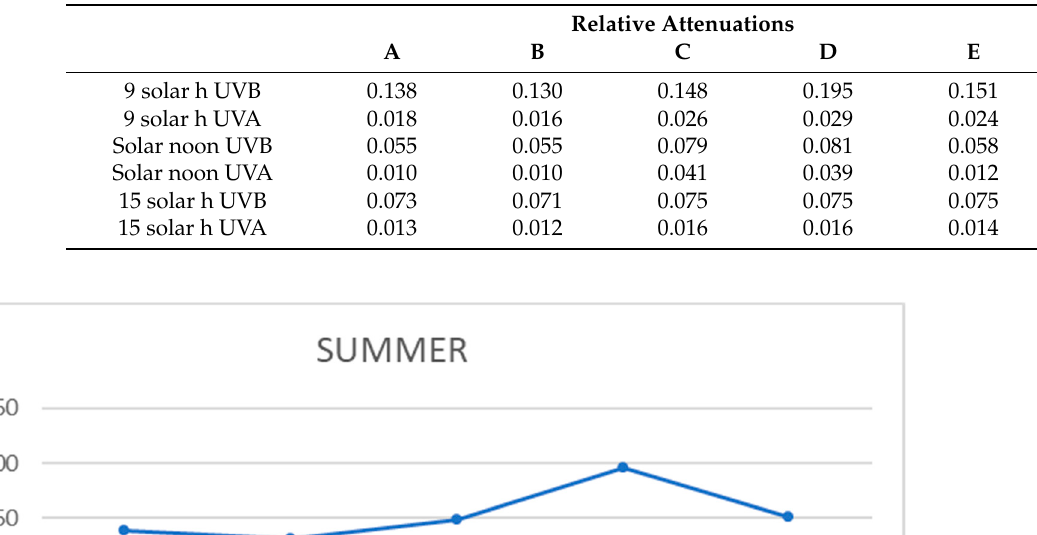
Table 3. Values of mean relative attenuations for the UVB and UVA bands in summer at three times of day.